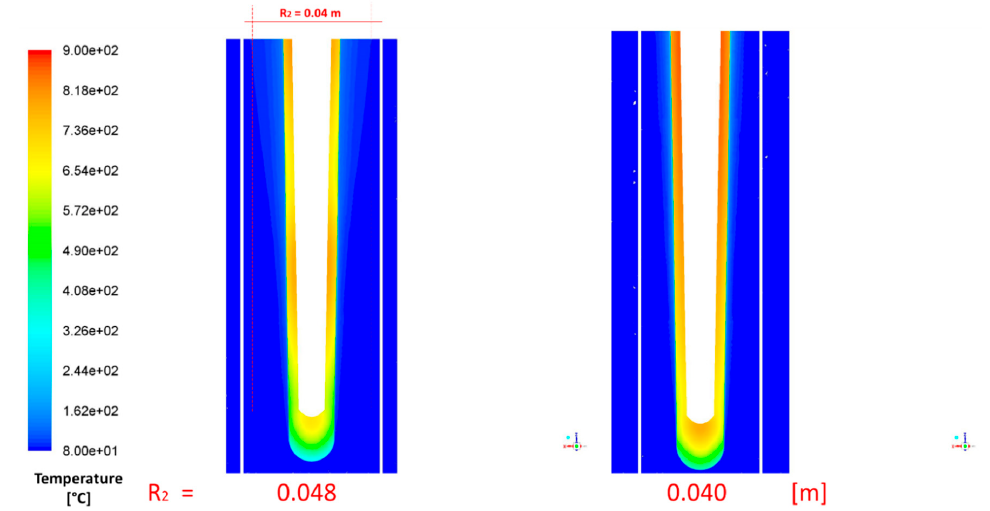
Figure 10. Temperature field comparison for R 2 equal to 0.048 and 0.040 m. Table 8. Comparison of R 2 = 0.048 m and original case.